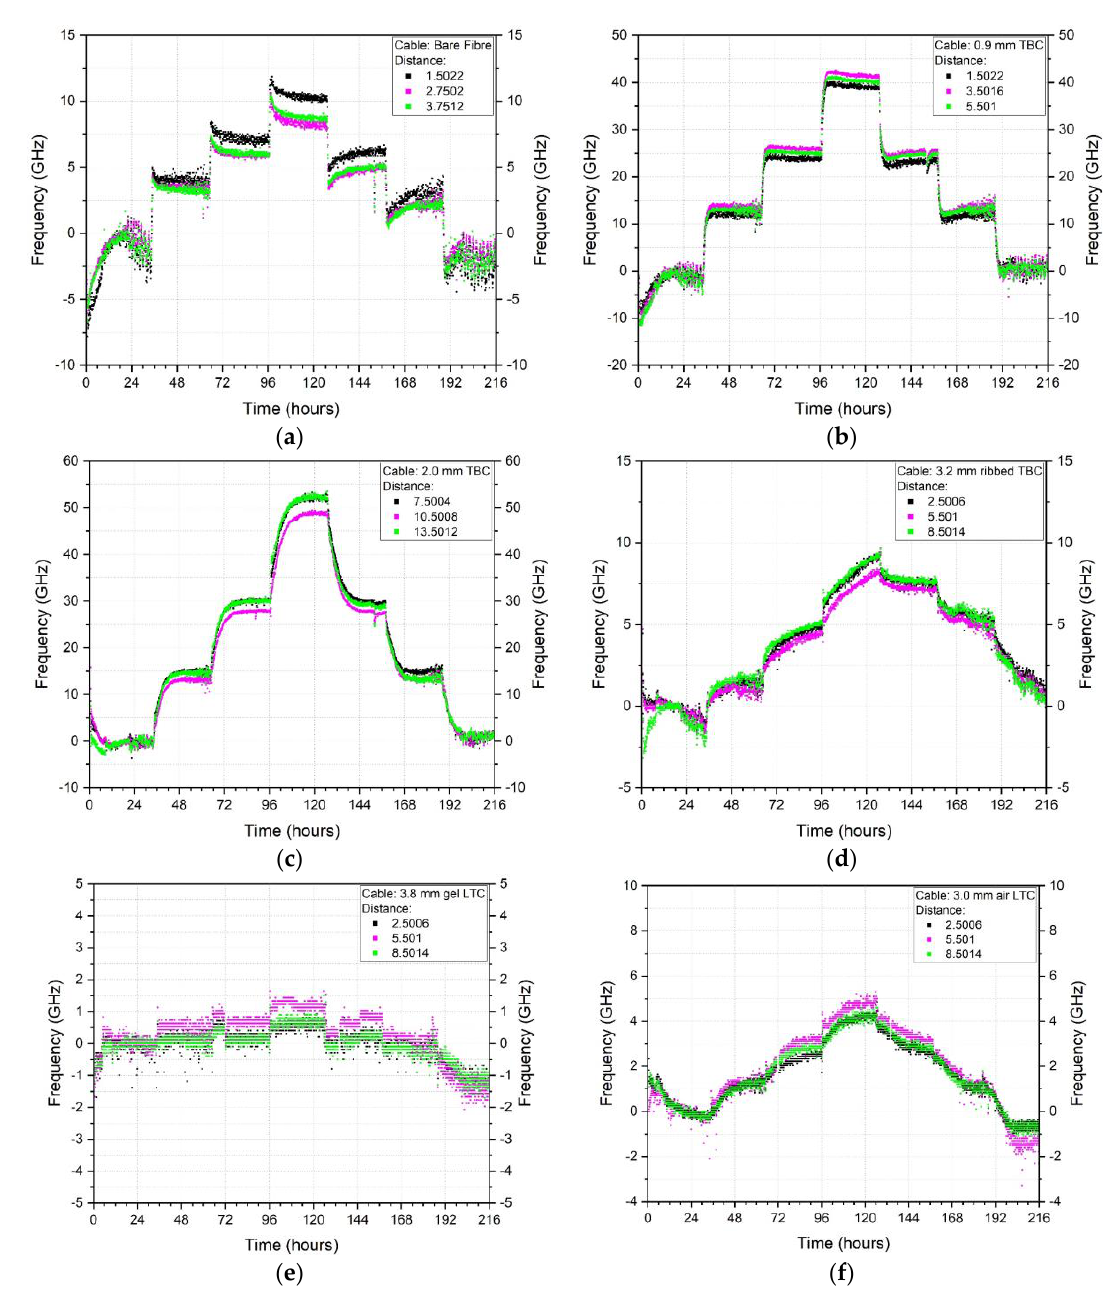
Figure A1. Time-Frequency plots for sustained temperature steps 10 – 60 – 10 – 10 °C for bare fibre